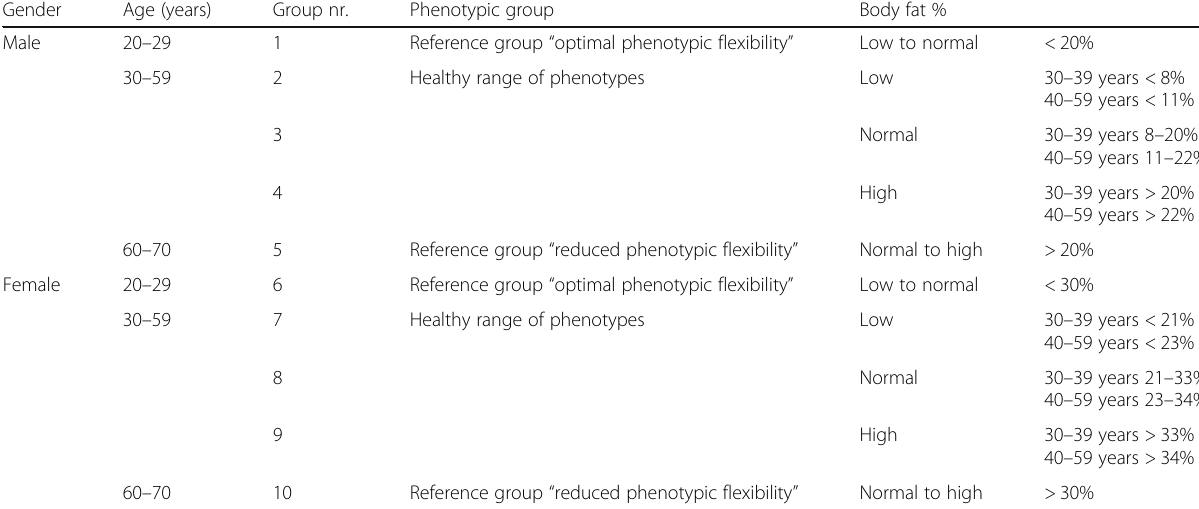
Table 1 Phenotypic groups of participants included in the study